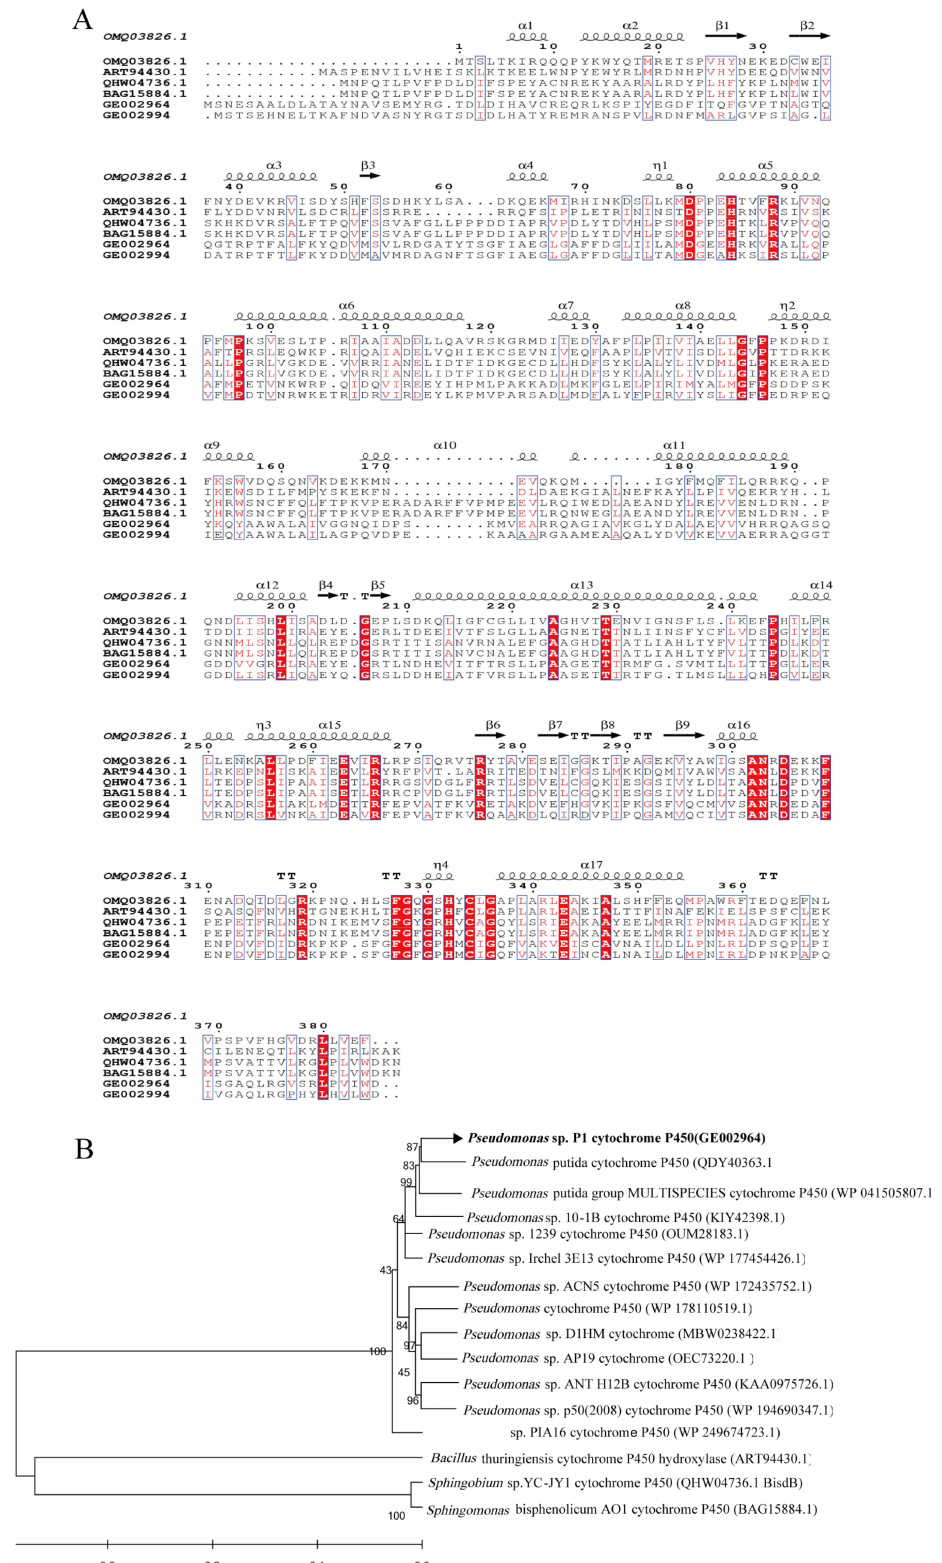
Figure 2. ( A ) Multiple sequence alignments for the Cytochrome P450 (GE002964, GE002994) com- pared to other homologs. ( B ) Phylogenetic reconstruction of Cytochrome P450 (CYP450) from strain P1 and other